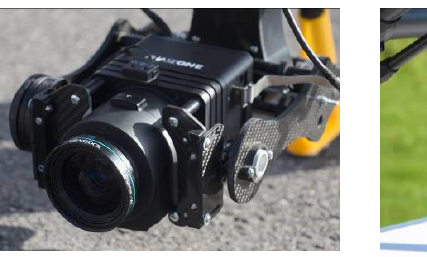
Table 1. Technical data of the camera systems under test